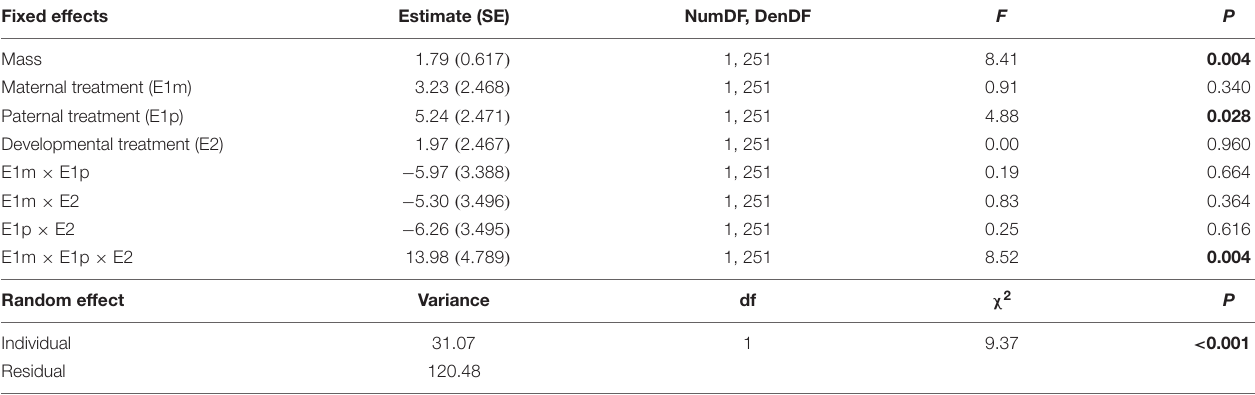
TABLE 2 | Results on the linear mixed model on